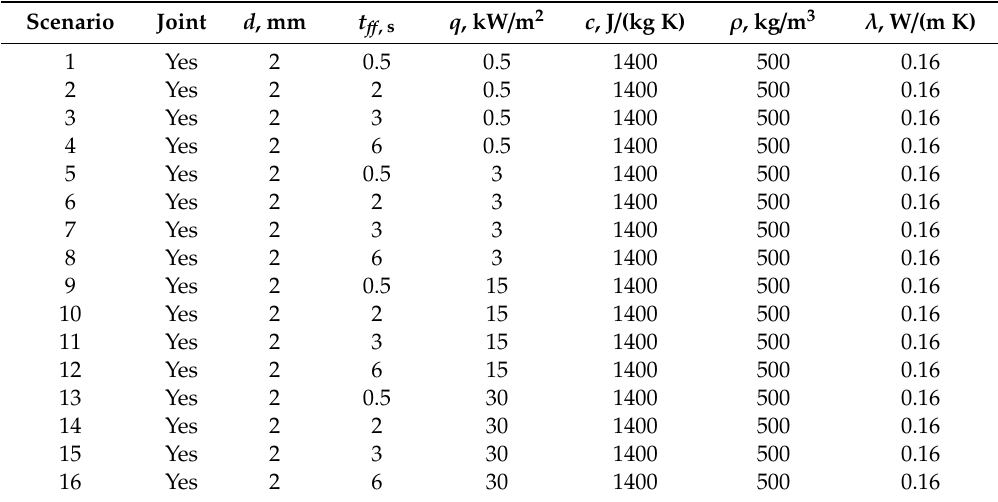
Table A4. The Main Scenarios of Forest Fire Impact on a Stem with a Joint. Part 1.